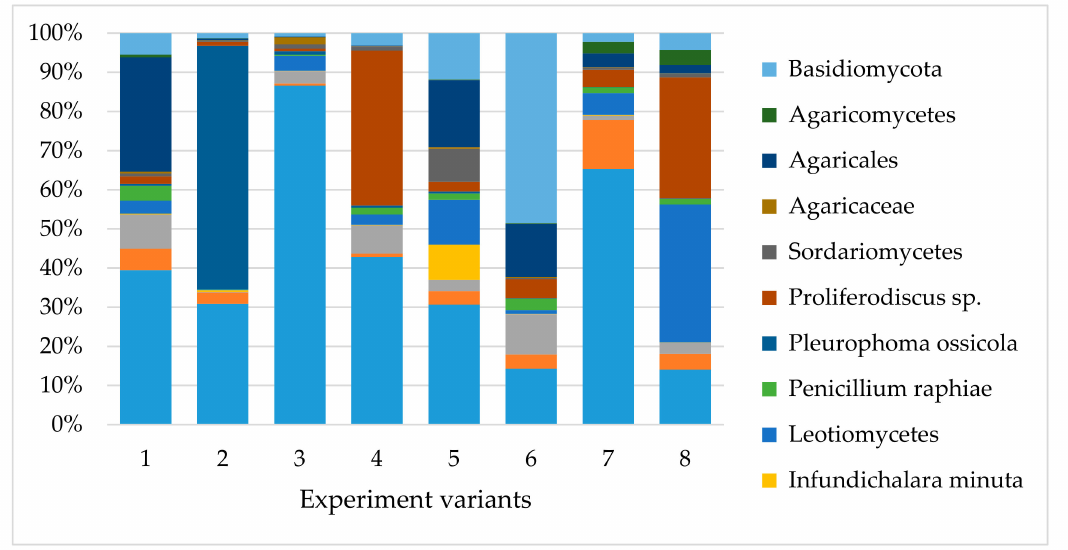
Figure 3. Relative abundance of taxa of the common fungi to all the variants of